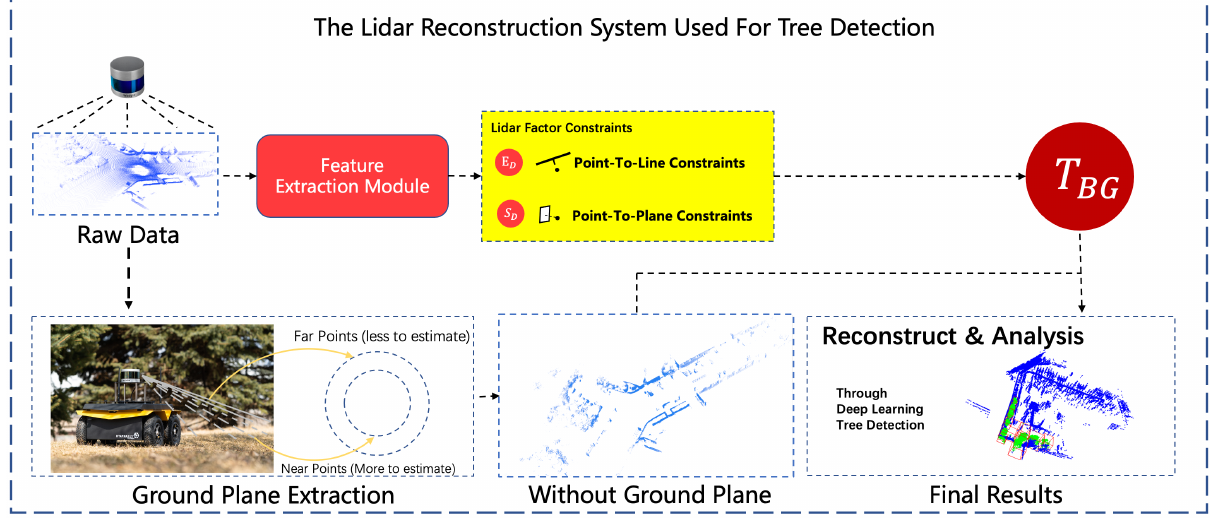
Figure 3. Pipeline of the reconstruction system. The whole system consist of four module: The feature extraction module, which uses the curvature to classify lidar points to point features and surf features. The ground plane extraction module which uses the concentric-zone model to filter out most messy ground plane information to build a clean reconstruction result. The lidar odometry estimation uses prior extracted features to estimate the lidar odometry. The reconstruction module uses the sensing data to build the global map. The reconstruction result is more suitable for vegetation’s height